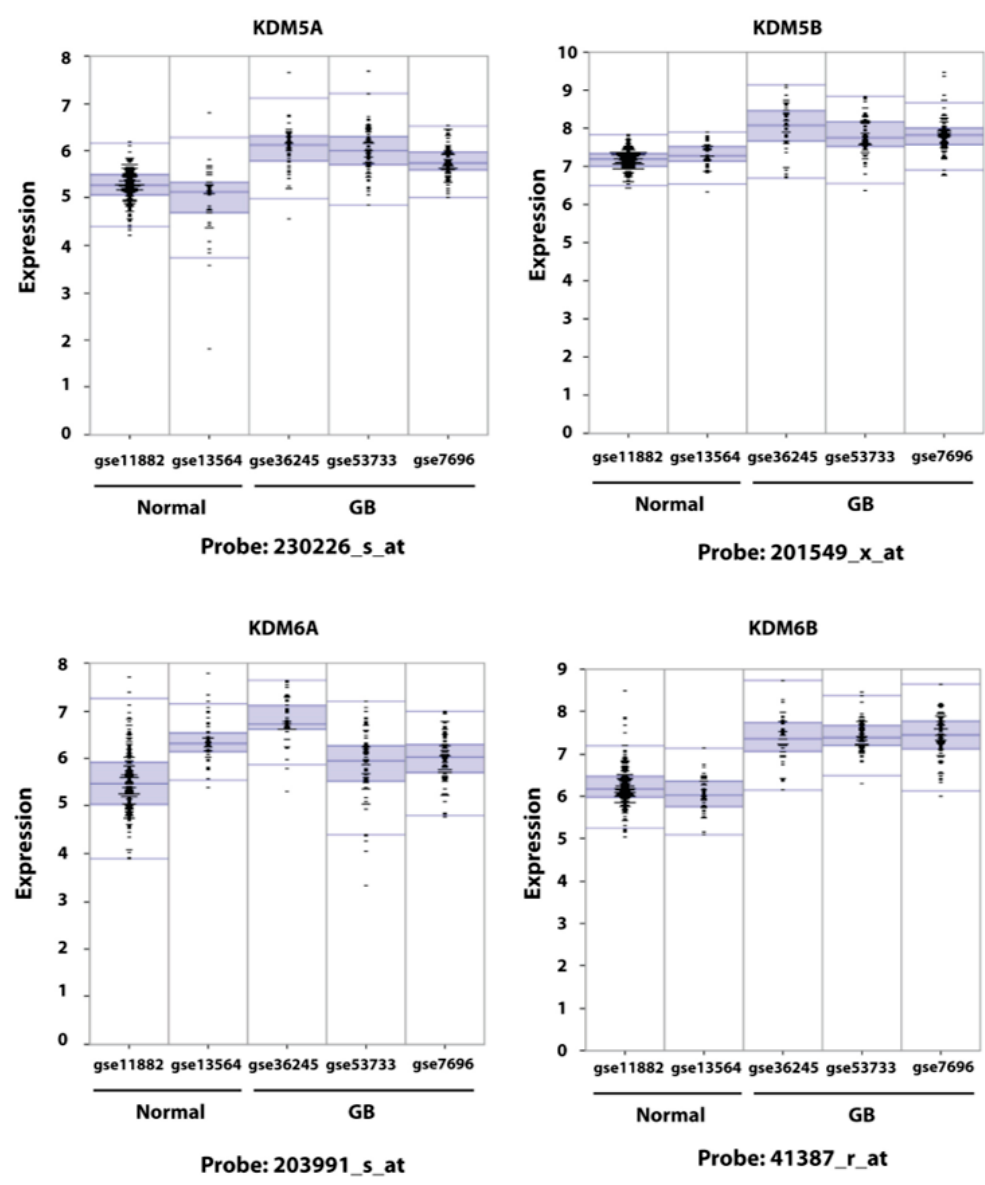
Figure 1. Expression of KDM5A/5B and KDM6A/6B in two normal brain and three